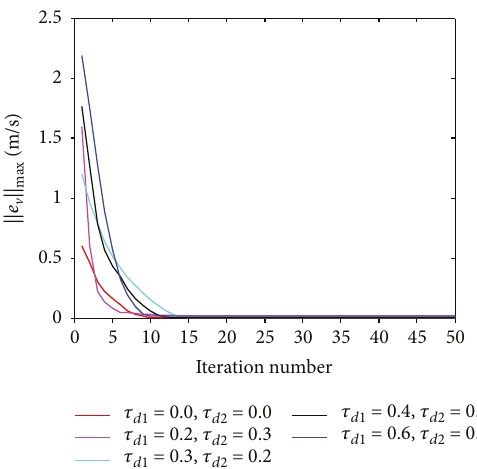
Figure 9: Maximum tracking errors of velocity with di ff erent time